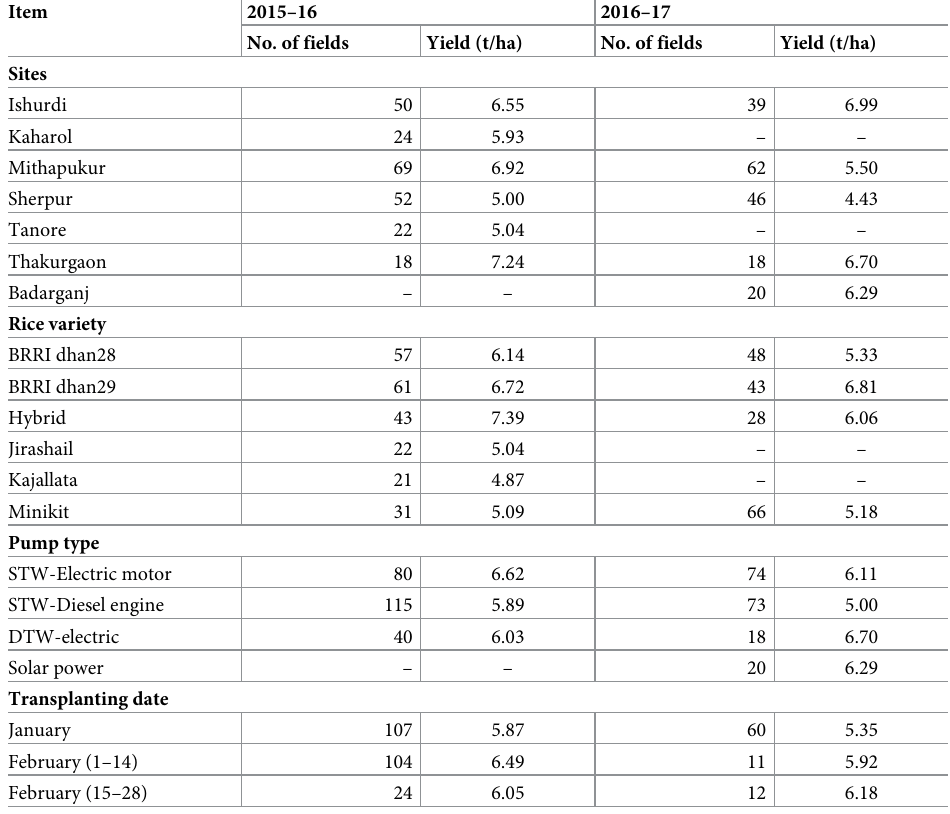
Table 3. Number of fields and mean actual or observed yield of Boro rice under different sites, pump-types, rice varieties and transplanting dates.